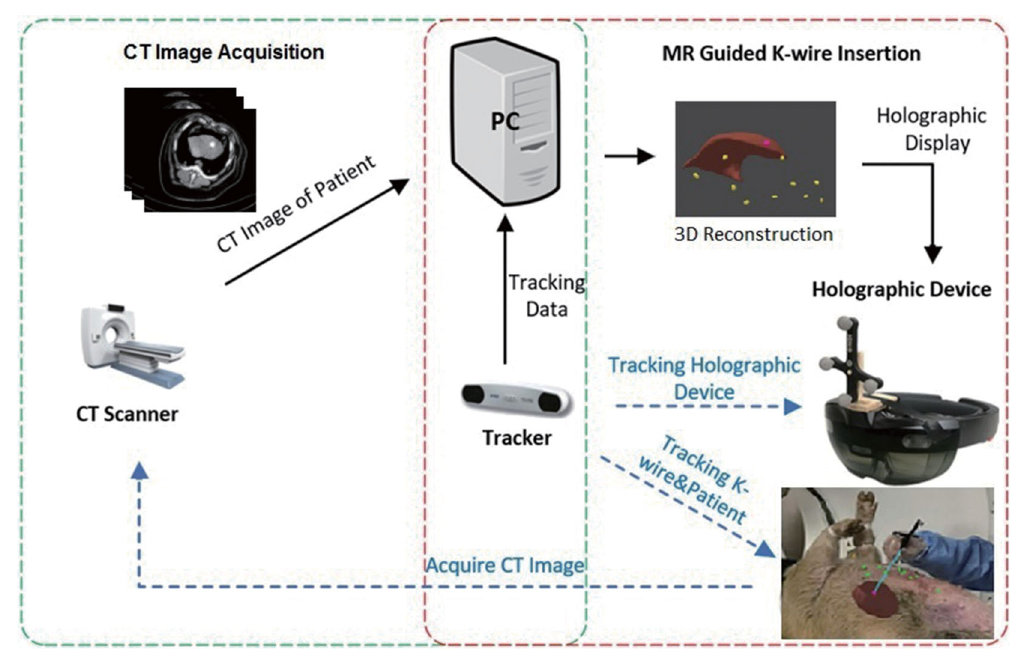
Fig. 1 Mixed reality-based needle insertion